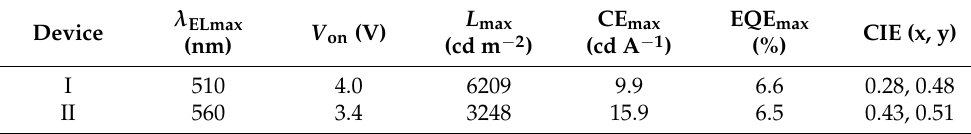
Figure 4. ( a ) Relative energy level alignments of the materials in the functional layers of the device. ( b ) Molecular structure of functional layer. ( c ) The J−V−L characteristics of devices. ( d ) The CE−J and EQE−J characteristics density of devices. Inset: the EL spectra of devices. Table 2. The data for electroluminescence performance of devices.